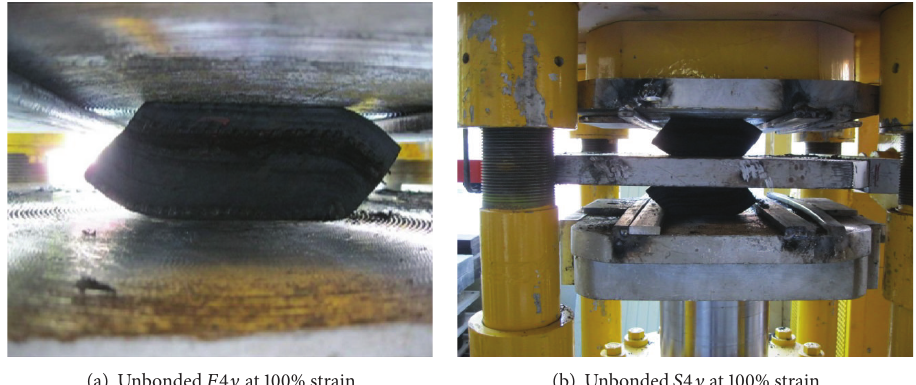
Figure 6: Deformation mode shape of fiber mesh-reinforced bearings.